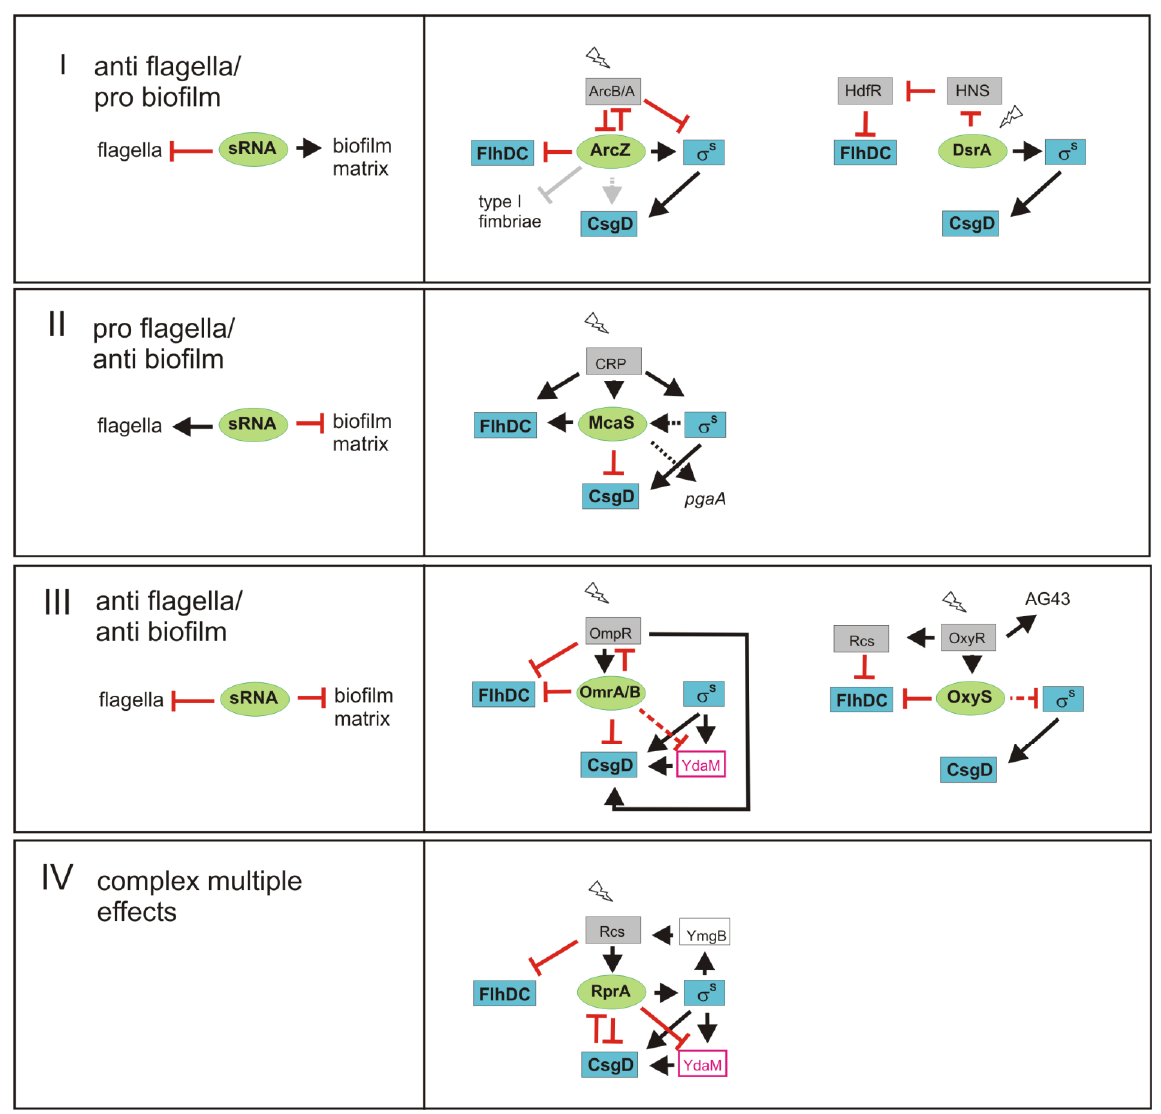
an explanation of the symbols, see legend of Figure 1. Grey arrows: shown in Salmonella